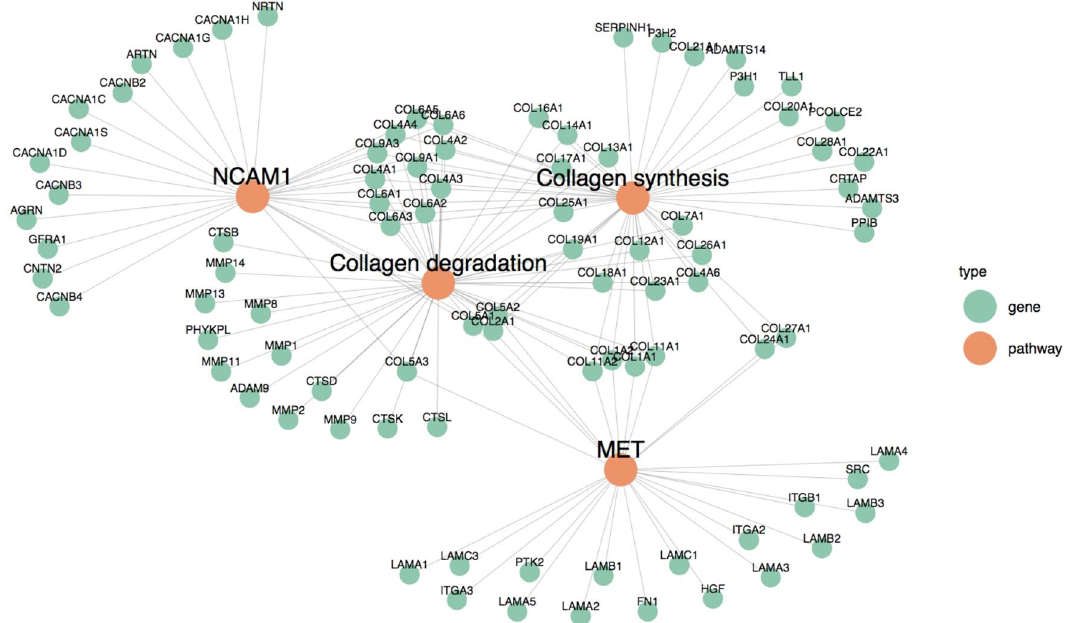
Figure 3. Cell proliferation pathways pertaining to collagen synthesis and degradation. This network diagram highlights the overlap of genes in the oncogenic pathways NCAM1 and MET. Edges connect SNV enriched genes to the pathways they are involved in, and show a central group of genes involved in multiple pathways converge into the collagen synthesis and degradation pathways. Mutations within COL5A1, COL5A2, COL5A3 and COL2A1 are shared by all four